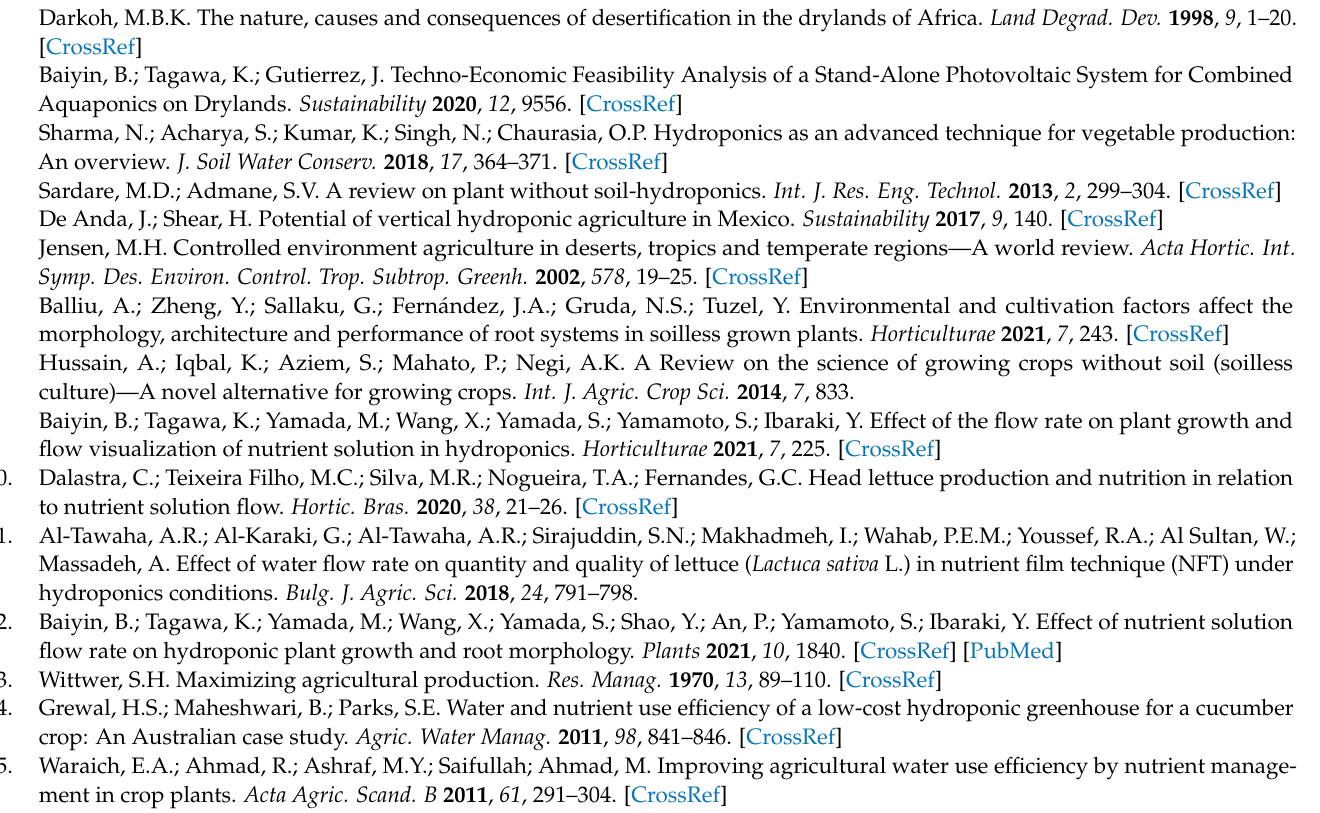
experiment, Table S2: The plant growth under different flow rates, Table S3: The nutrient contents of the plant under different flow